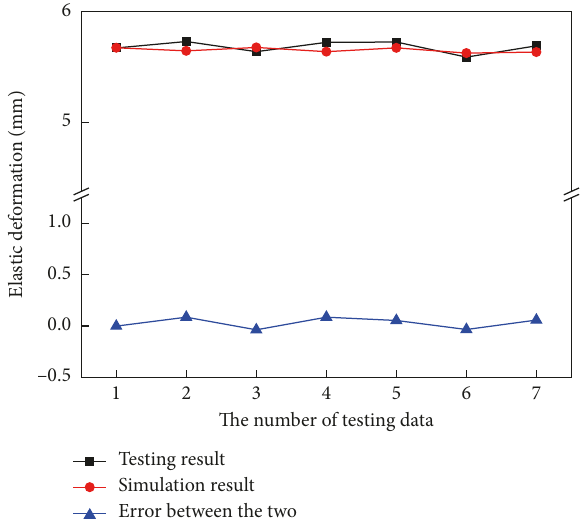
Figure 12: Comparison between the testing results and the sim- ulation